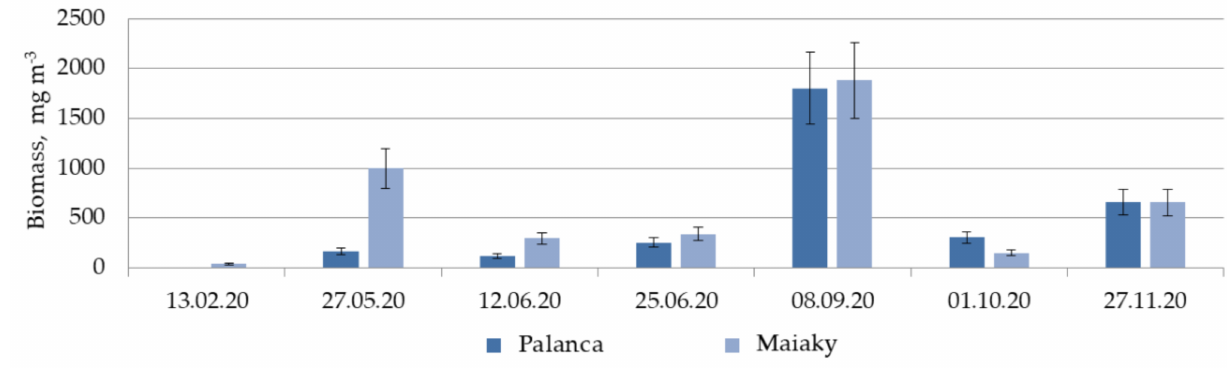
Figure 6. Seasonal changes of phytoplankton biomass (average ± SE) in two sites of the Lower Dniester (2020).